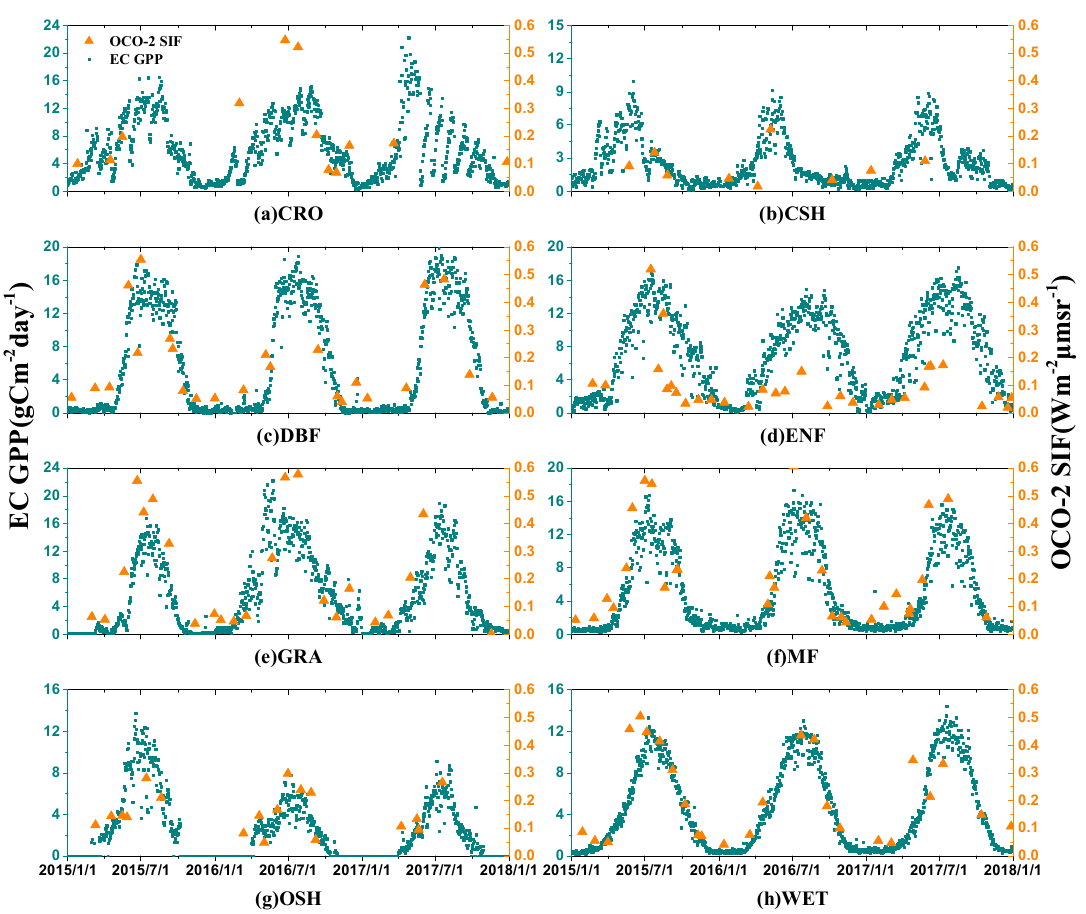
Figure 4. The seasonal trends of tower GPP and SIF757 from January 1, 2015 to January 1, 2017, for different vegetation types: (a) CRO, (b) CSH, (c) DBF, (d) ENF, (e) GRA, (f) MF, (g) OSH, and (h) WET. The dot indicates flux tower GPP measurements, and the triangle indicates OCO-2 SIF757 data.